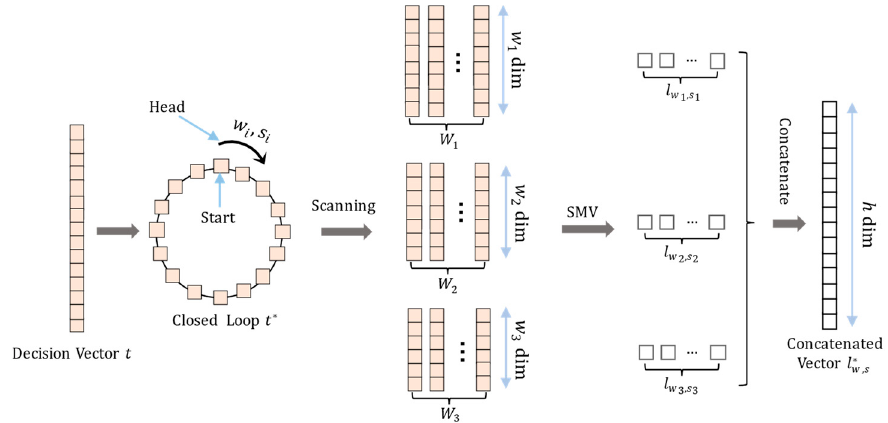
Figure 3. The flow chat of circular multi-grained scanning.